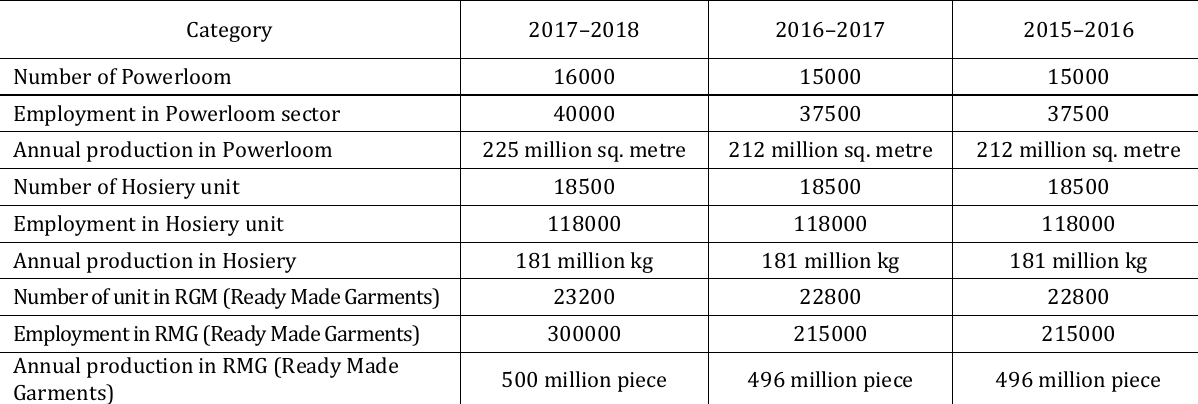
Table 2. Table showing various data related to Power loom, Hosiery Unit and Ready Made Garment (Source: Economic